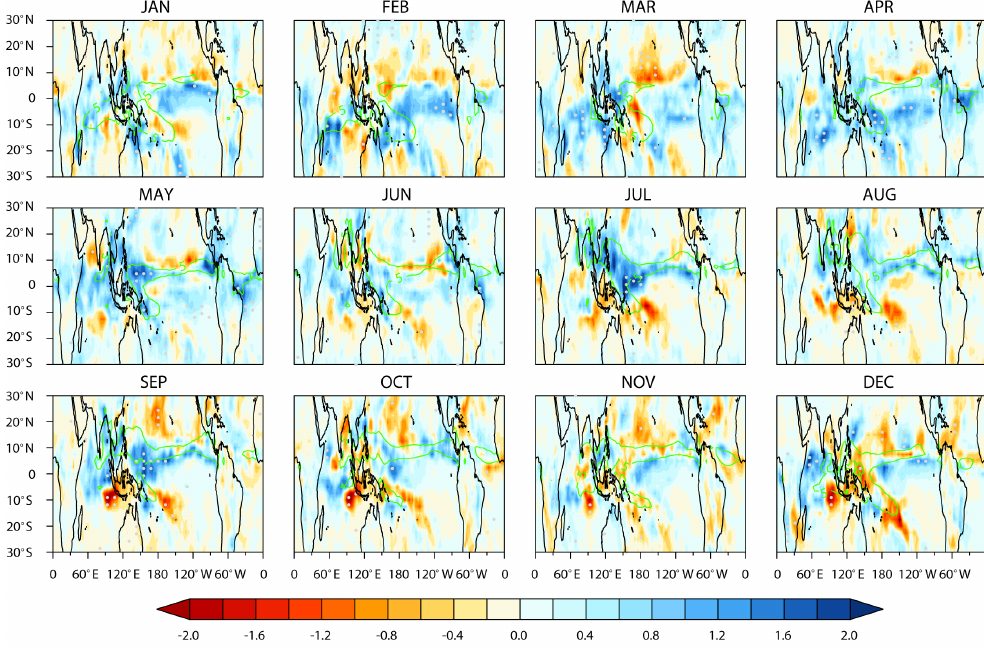
Figure 10. Latitude–longitude distributions of monthly averaged W–E QBO differences from the regression analysis of convective precipita- tion data (mm per day) from the ERA-I dataset for 1958–2016. The EOF-based approach has been employed to define the QBO index, using φ =− 60 ◦ (see text), which is approximately equivalent to defining the QBO by U eq = 70hPa.